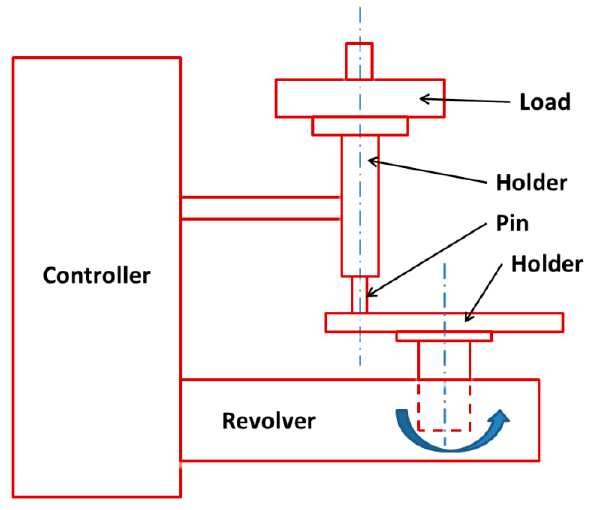
Figure 2. The schematic diagram of the ML-100 type abrasive wear